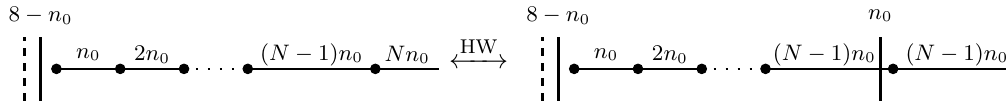
Figure 3. Left: massive Type IIA configuration dual to the F-theory electric quiver in (2.11). Right: massless Type IIA configuration (orbi-instanton) with k − n 0 semi-infinite D6’s obtained from the massive setup at the top via n Hanany-Witten (HW) 0